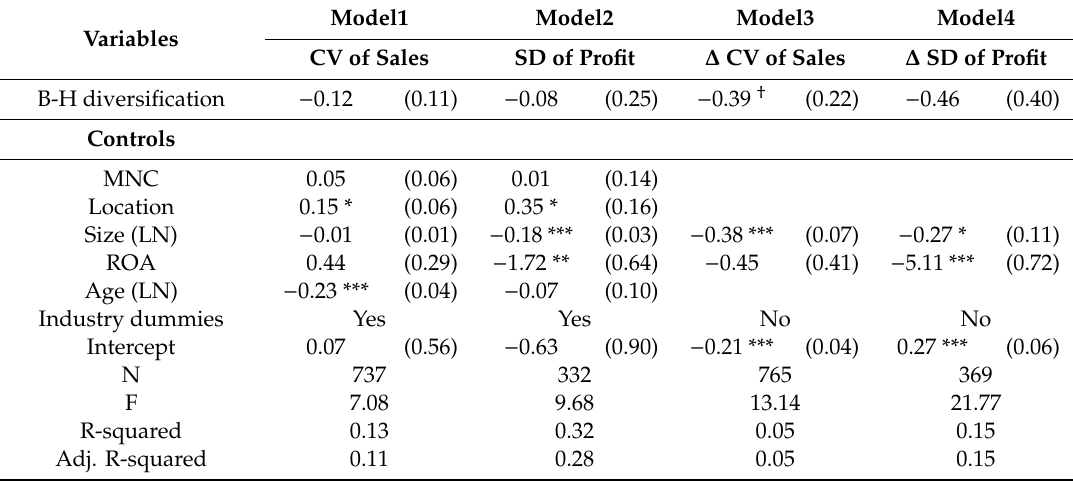
Table 4. E ff ect of Diversification Measured by the Berry-Herfindahl Method.